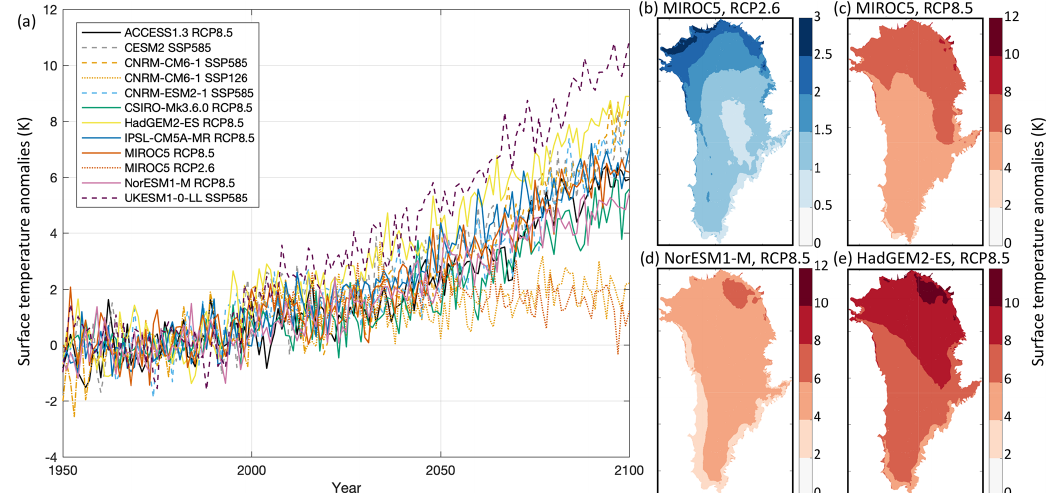
Figure 4. Surface temperature anomalies (K) over the Greenland ice sheet under the RCP2.6, RCP8.5, SSP1-2.6, and SSP5-8.5 scenarios. (a) Time series of mean surface temperature anomaly from 1950 to 2100 for all AOGCMs and scenarios selected and (b–e) surface tempera- ture anomaly over the time period 2081–2100 for (b) MIROC5 under RCP2.6, (c) MIROC5 under RCP8.5, (d) NorESM1-M under RCP8.5, and (e) HadGEM2-ES under RCP8.5.